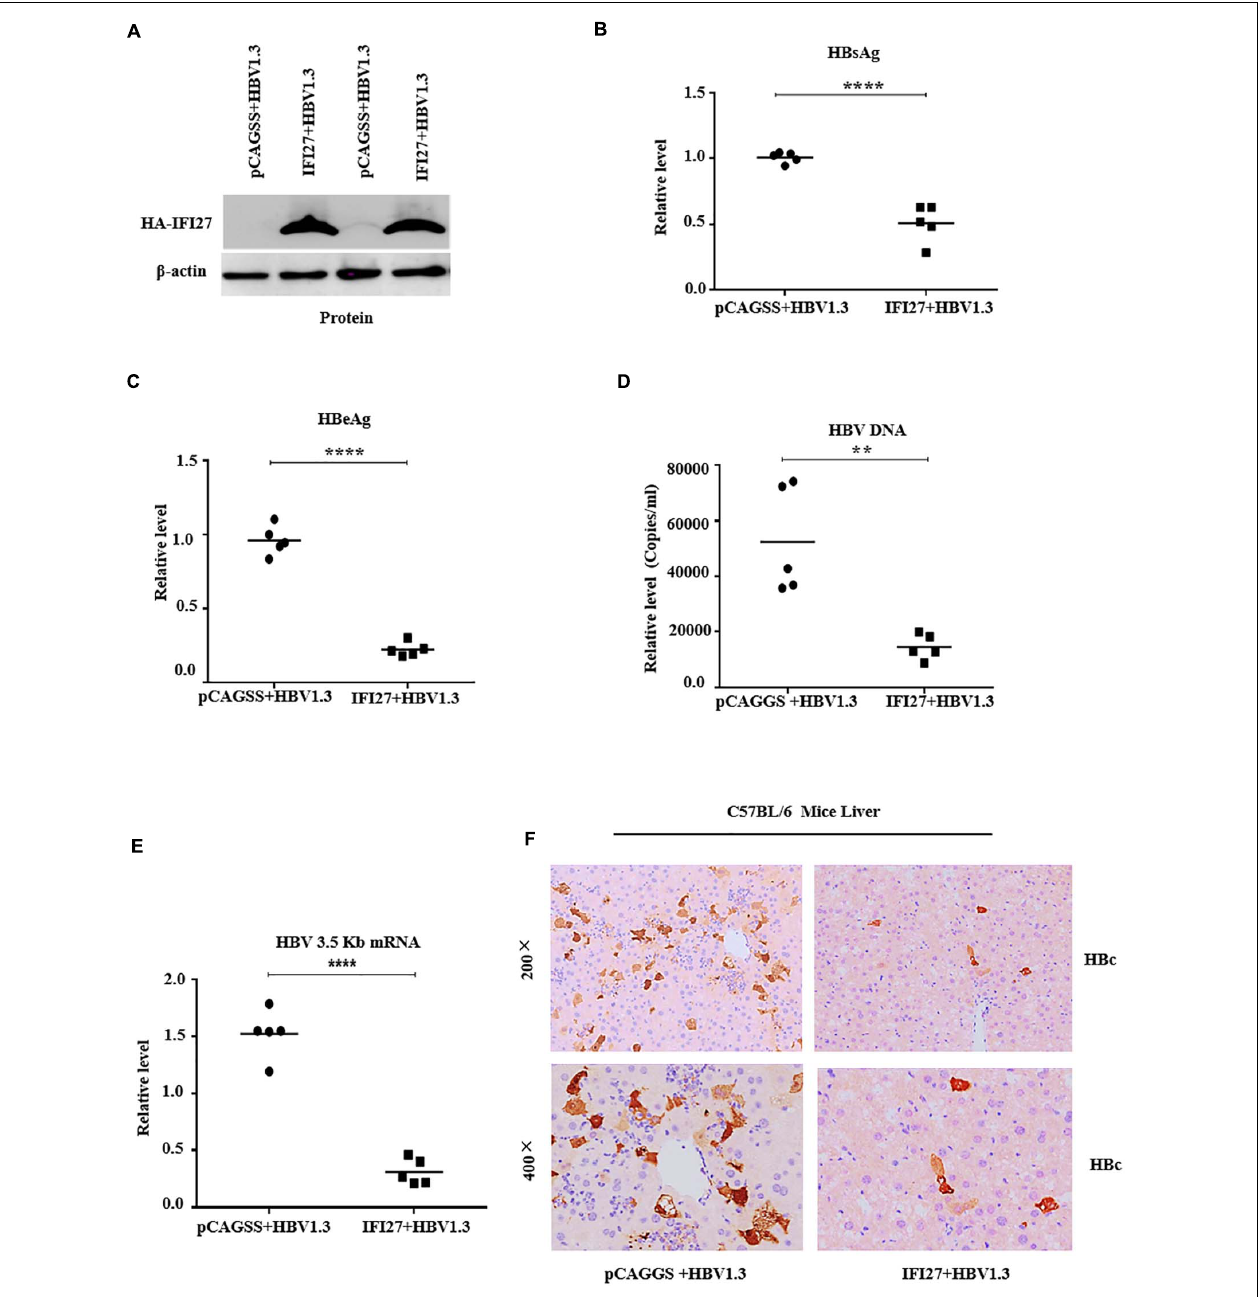
FIGURE 6 | IFI27 suppresses HBV replication and gene expression in vivo. (A–F) Two groups of C57BL/6 mice ( n = 10) were co-injected with pHBV1.3 along with pCAGGS-HA-IFI27 or pCAGGS. After 4 days of hydrodynamic injection, the mice were sacrificed and the livers and blood were processed for analyses. (A) The expression level of IFI27 was determined by western blot using anti-HA antibodies, and the levels of β -actin serve as loading controls (lower panel). (B,C) The titer of secreted HBsAg (B) and HBeAg (C) proteins expressed in mice blood was measured using ELISA. (D) The level of HBV DNA from sera was also evaluated using qPCR. (E) Total HBV RNA was isolated from the liver tissues, and the levels of HBV pgRNA were measured by qRT-PCR. The level of mice GAPDH (mGAPDH) was used as an internal control. (F) Immunohistochemical staining was used to determine the HBcAg levels in the liver. ** P ≤ 0.01, **** P ≤